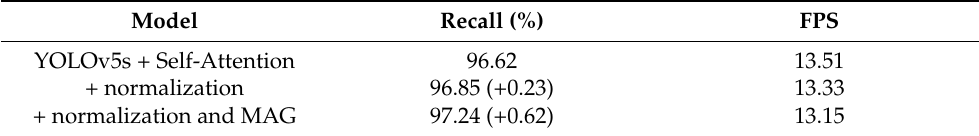
Table 3. The influences of the normalization and MAG.